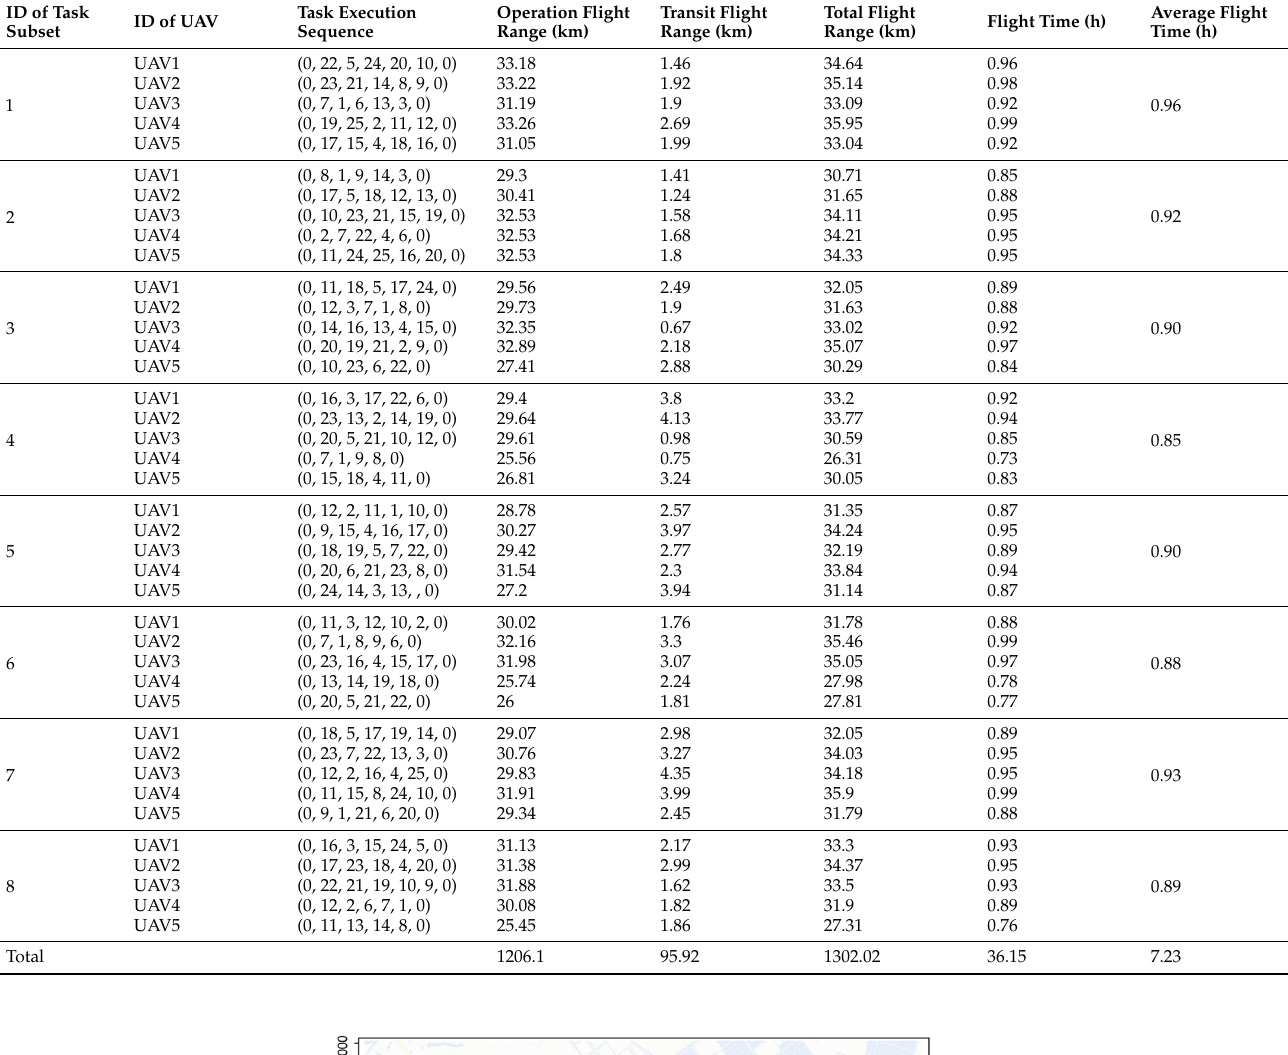
Table 3. Results of the scheduling scheme.